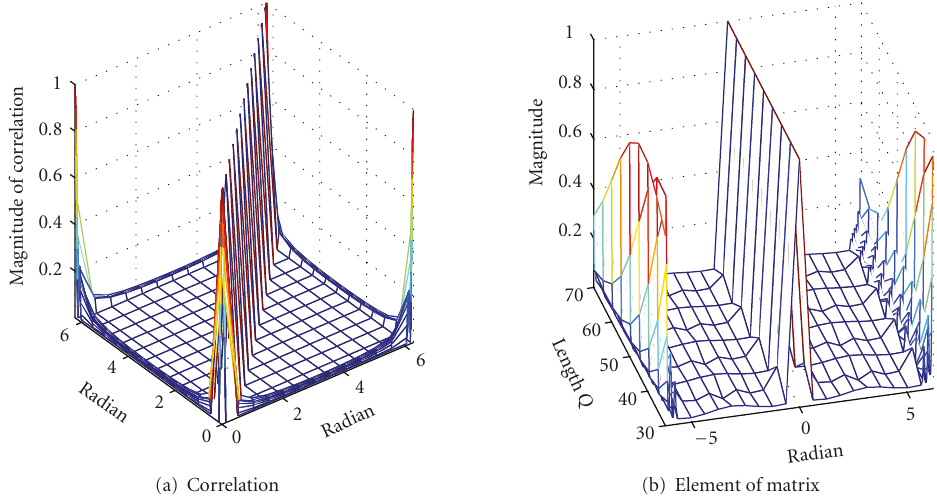
Figure 1: Illustration of the entries of F T in (18) versus various Q and the di ff erence ω (cid:2)